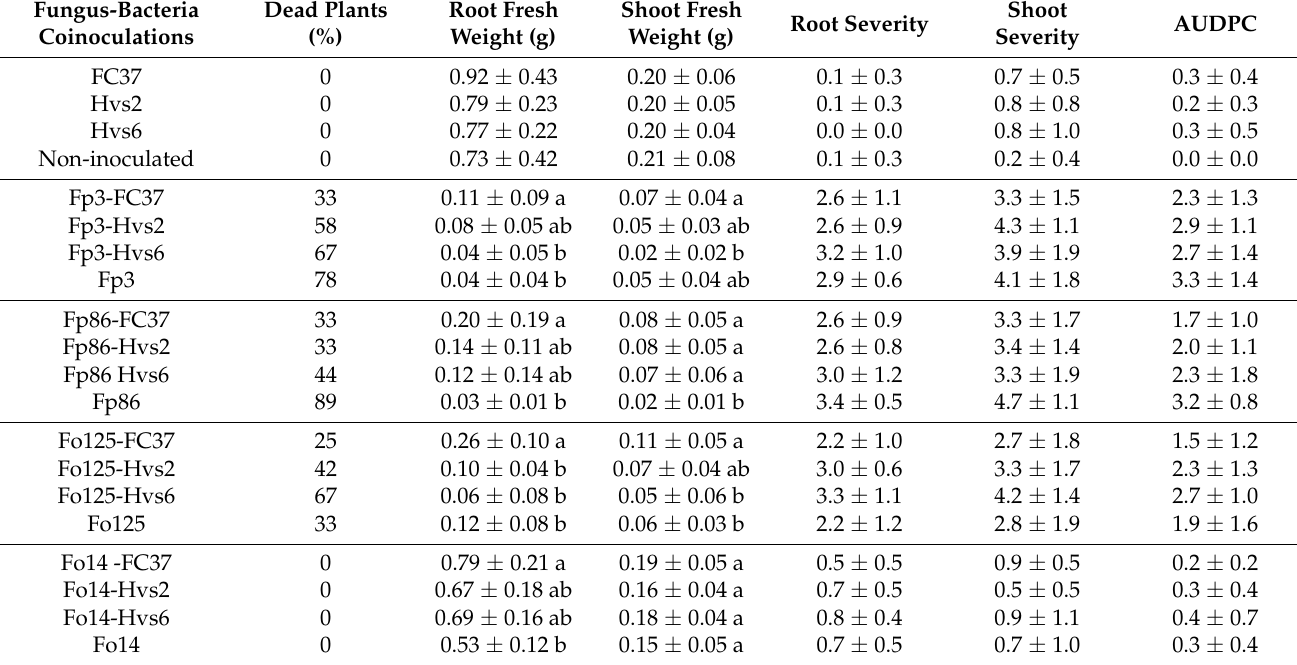
Table 1. Percentage of dead plants, root and shoot fresh weight, symptoms severity and the area under the disease progress curve (AUDPC) for in planta assays of coinoculations of Fusarium proliferatum (isolates Fp3 and Fp86), and F. oxysporum f. sp. asparagi (isolates Fo14 and Fo125) and the bacterial strains FC37, Hvs2, and Hvs6. Data are mean ± standard deviation of 9–12 plants. For each fungal isolate, different letters indicate significant differences among treatments ( p ≤ 0.05).